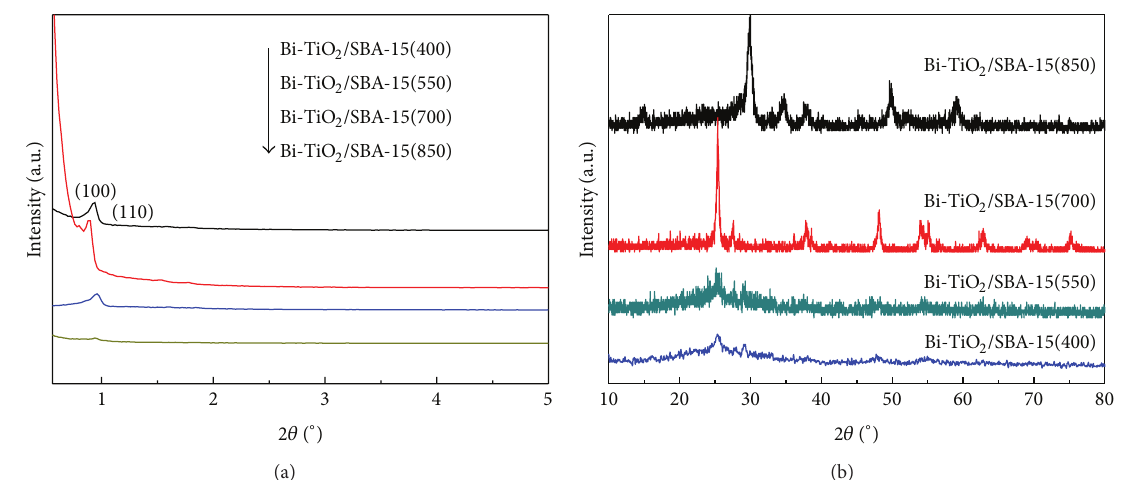
Figure 1: Small-angle (a) and wide-angle (b) XRD patterns of Bi-TiO 2 /SBA-15( x ). Table 1: Textural properties of Bi-TiO